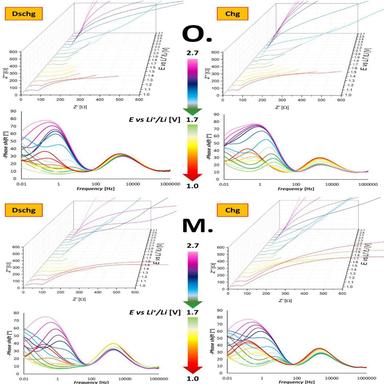
Nyquist and Bode phase plots of the EIS measurements, for orthorhombic (up) and monoclinic (down) FeNb11O29. Both discharge (left) and charge (right) spectra are shown.